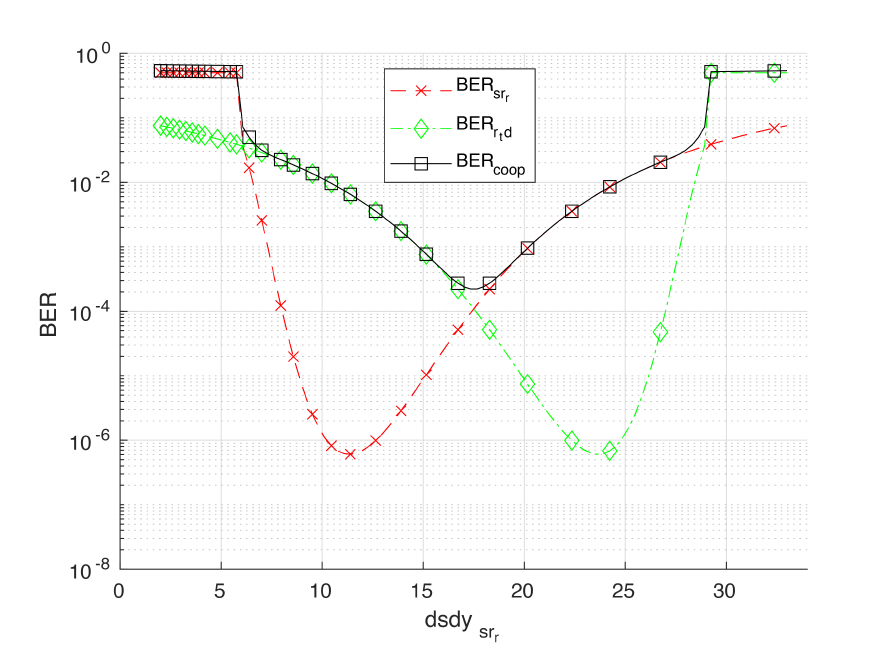
Figure 7. Results for the cooperative BER associated with the scenario D in Figure 5d, considering an intermediate